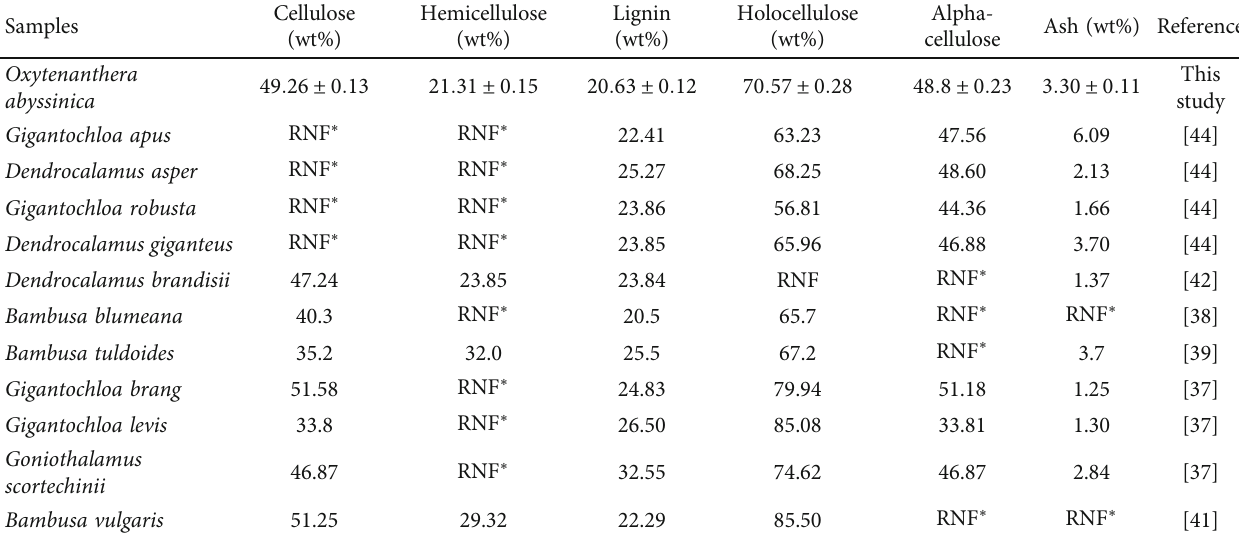
Table 1: Chemical composition comparison of ROA to other bamboo